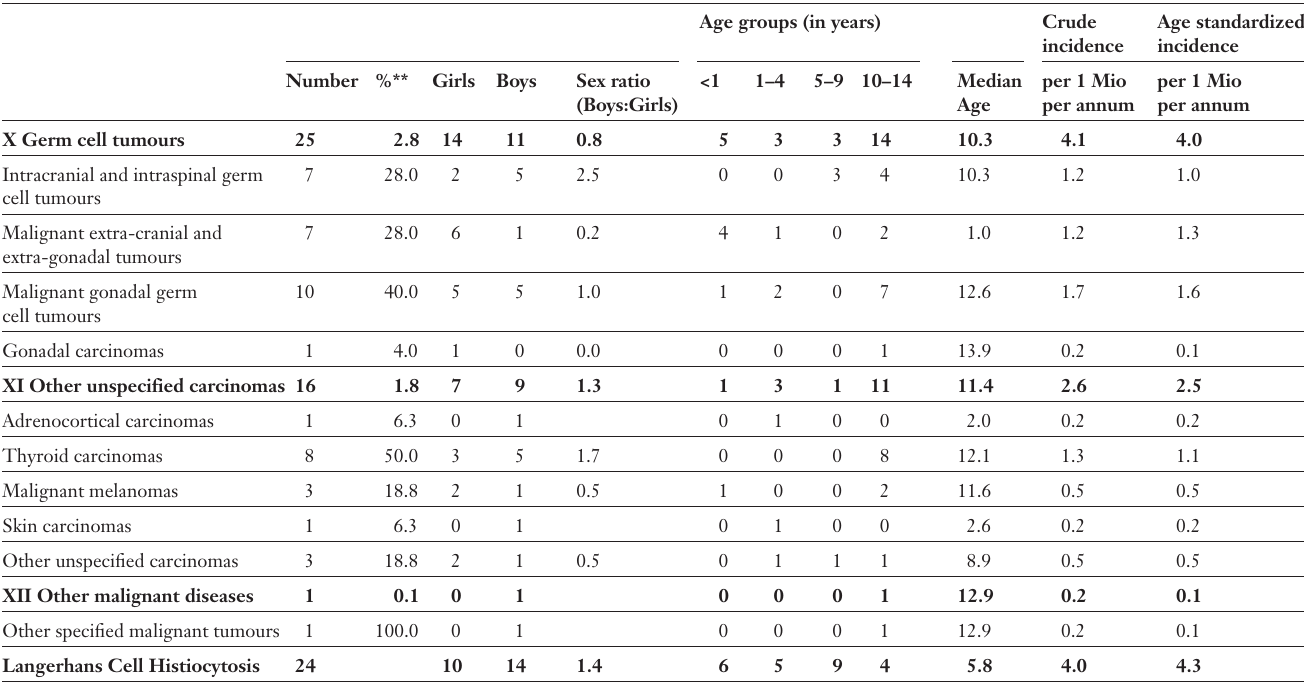
Figure 1 Gender and age-spe- cific incidence rate of childhood malignan- cies registered in the SCCR (Swiss children diagnosed